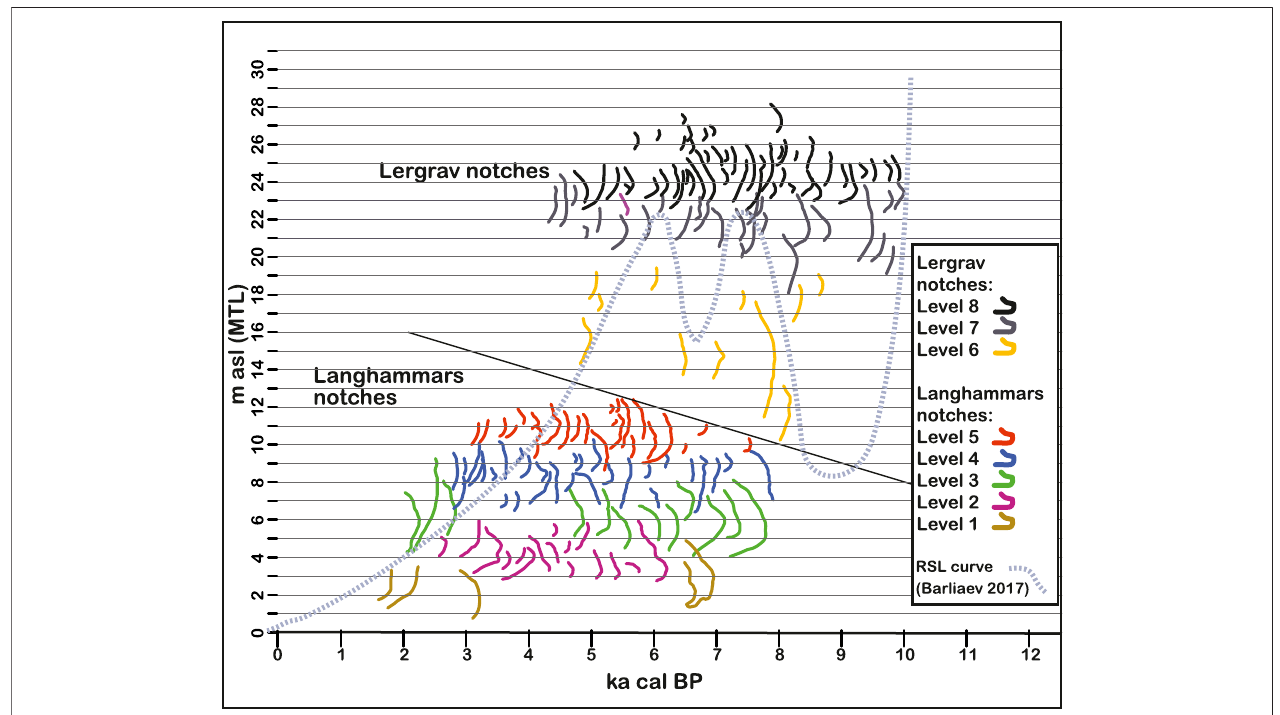
FIGURE6| Levelsofupliftedpaleo-notchesinLanghammars(levels1 – 5)andLergrav(Levels6 – 8)detectedbyTLS.Therelativesea-levelcurveinthebackground after Barliaev (2017). Note two-phased Littorina Sea transgression that could have a signi fi cant effect on wave-cutting of bigger notches in rauks emerging from Baltic between6,000 — 8,000 yearsago.Deepernotchesstarttoformca.4,000 yrsago,whenthemodernBalticSeawasestablished,andtherateoflandupliftsloweddown allowing wave action to operate longer on the same rock surface.